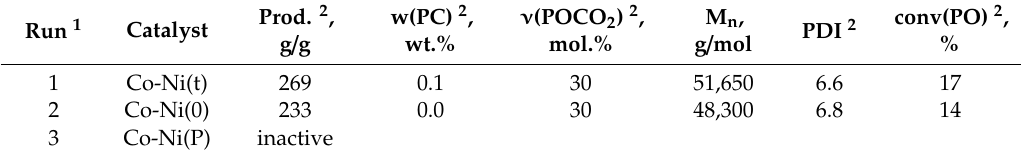
1 Reaction conditions: PO / cat = 1330 g / g (cat is the abbreviation for catalyst), poly(propylene glycol) (PPG)-425 / cat = 0.024 mol / g, 90 ◦ C, 3 h, copolymerization method I, initial pressure 2.0 MPa (r.t.), reaction pressure